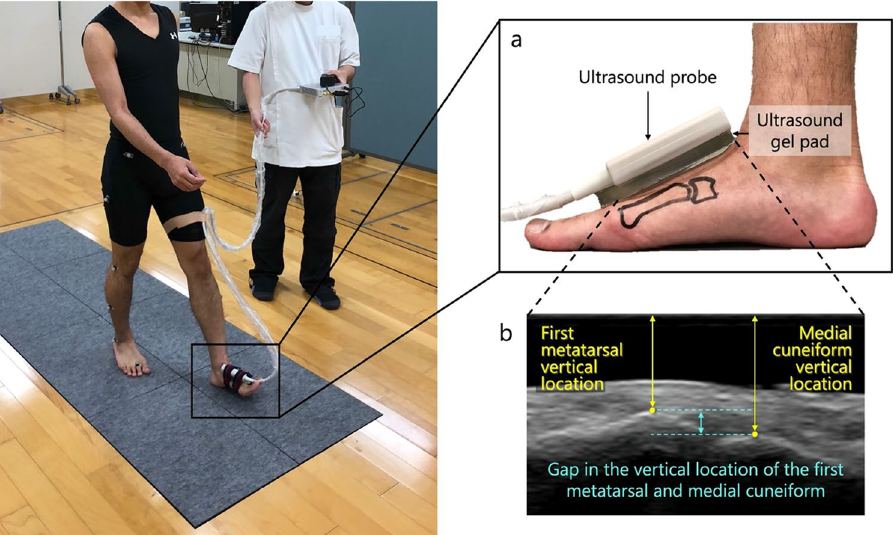
Figure 2. Gait analysis using ultrasound and a three-dimensional motion analysis system. Ultrasound probe was attached at the tarsometatarsal joint on an ultrasound gel pad ( a ), and the first metatarsal and medial cuneiform were within the field of view ( b ). The vertical locations of the first metatarsal and medial cuneiform were defined as the vertical distance from the screen top to the dorsum of each